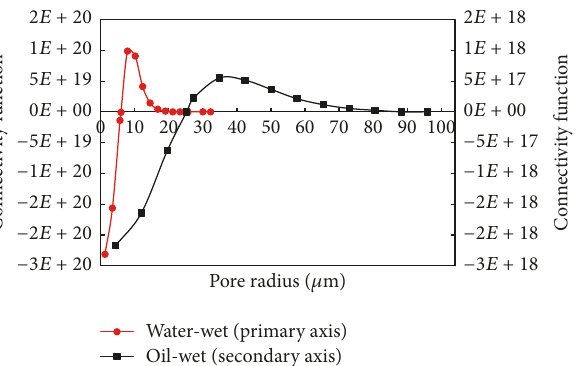
Figure 4: Pore size distribution.